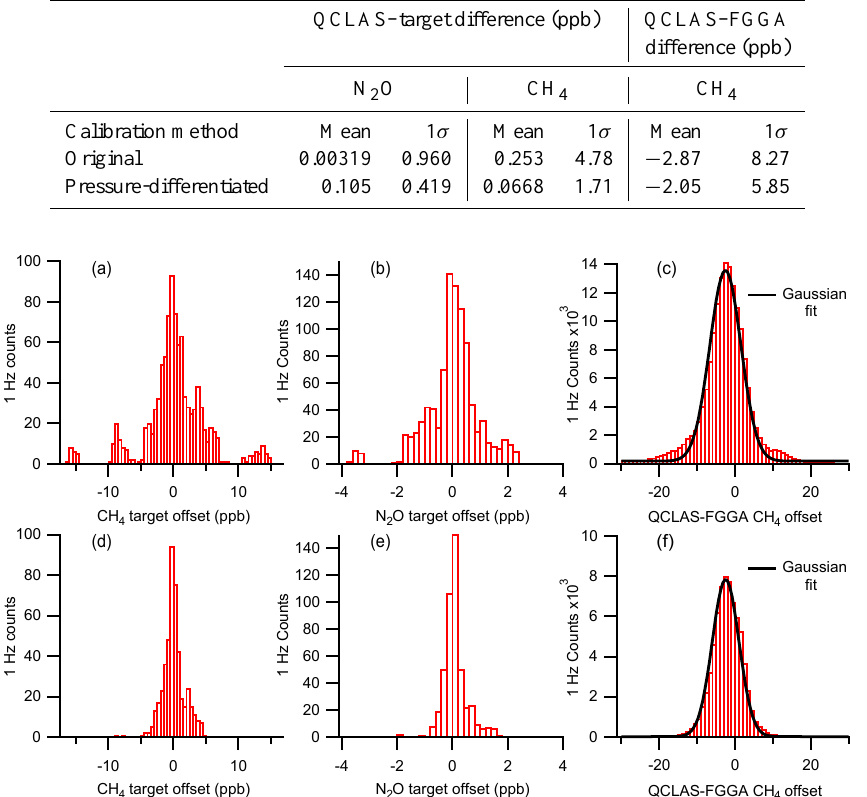
Figure 9. Histograms showing the offset between the calibrated 1Hz QCLAS measurements and both the corresponding target cylinder values and the corresponding FGGA sample measurements. Panels (a) – (c) show histograms for data calibrated using the original method; in comparison, panels (d) – (f) show the corresponding histograms using the pressure-differentiated calibration method. It can be seen here that the pressure-differentiated method results in the removal of many of the outlying target cylinder measurements. In addition, the Gaussian fit to the QCLAS–FGGA CH 4 offset is also improved by the pressure-differentiated calibration method (f) relative to the original method (c)